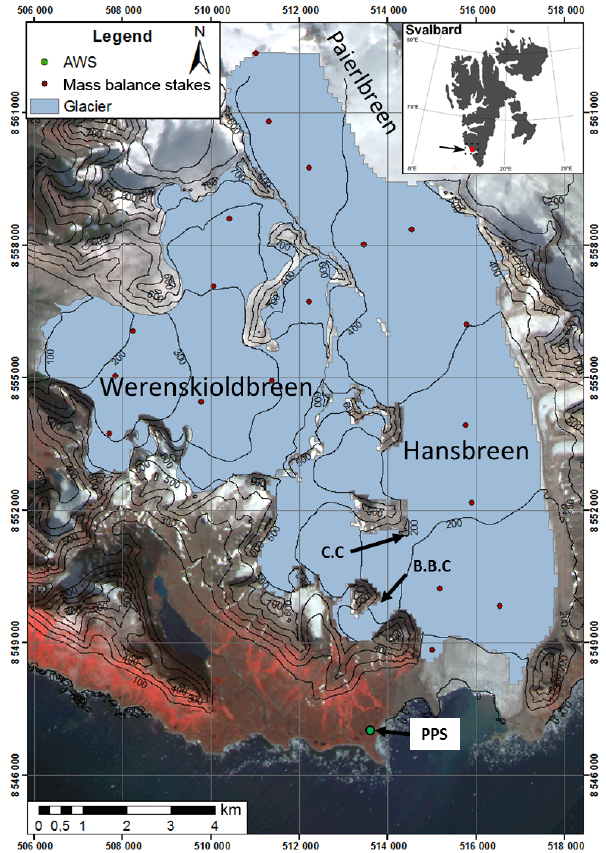
Figure 1. Map showing the locations of Hansbreen and Werenski- oldbreen, Svalbard, the automatic weather station (AWS), the Pol- ish Polar Station (PPS), the mass balance stakes network, Crystal Cave (CC) and Bird Brain Cave (BBC). The background map is a SPOT satellite image acquired on 16 August 1988 and the coordi- nate system used is WGS 1984 UTM zone 33 ◦